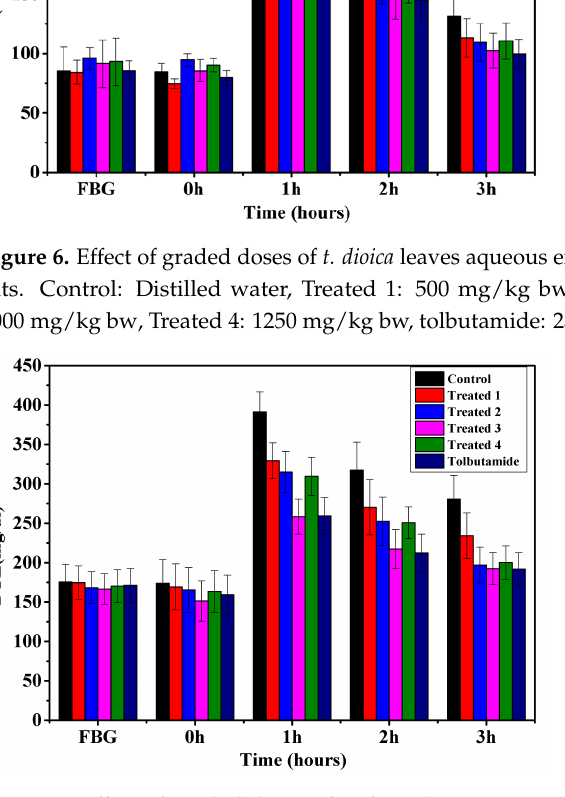
Figure 7. Effect of graded doses of t. dioica leaves aqueous extract on BGL during GTT in mildly diabetic rats. Control: Distilled water, Treated 1: 500 mg/kg bw, Treated 2: 750 mg/kg bw, Treated 3: 1000 mg/kg bw, Treated 4: 1250 mg/kg bw, tolbutamide: 250 mg/kg